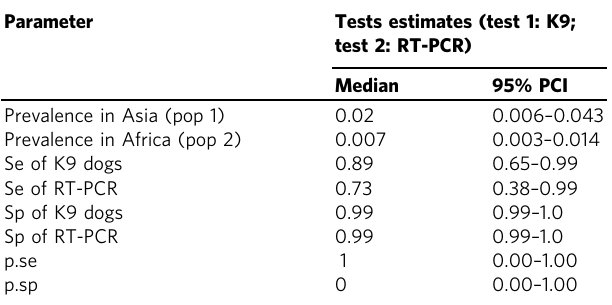
Table 5 Test estimates of two screening tests K9 and RT_PCR for diagnosis of COVID-19 in the human population ( n = 3134) in